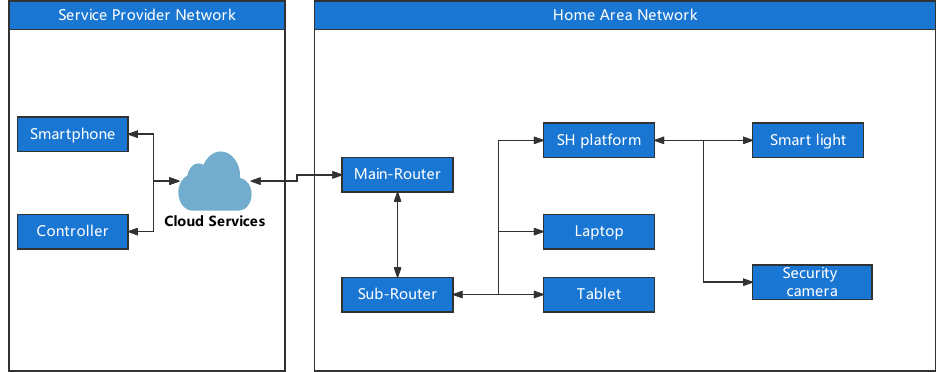
Figure 2. The architecture of test-bed